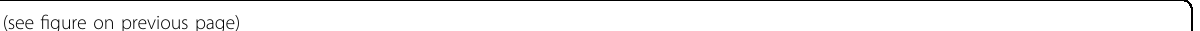
Fig. 6 Lgals3bp de fi ciency-induced exacerbation of colon tumorigenesis via GM-CSF-mediated MDSC accumulation. A WT and Lgals3bp − / −